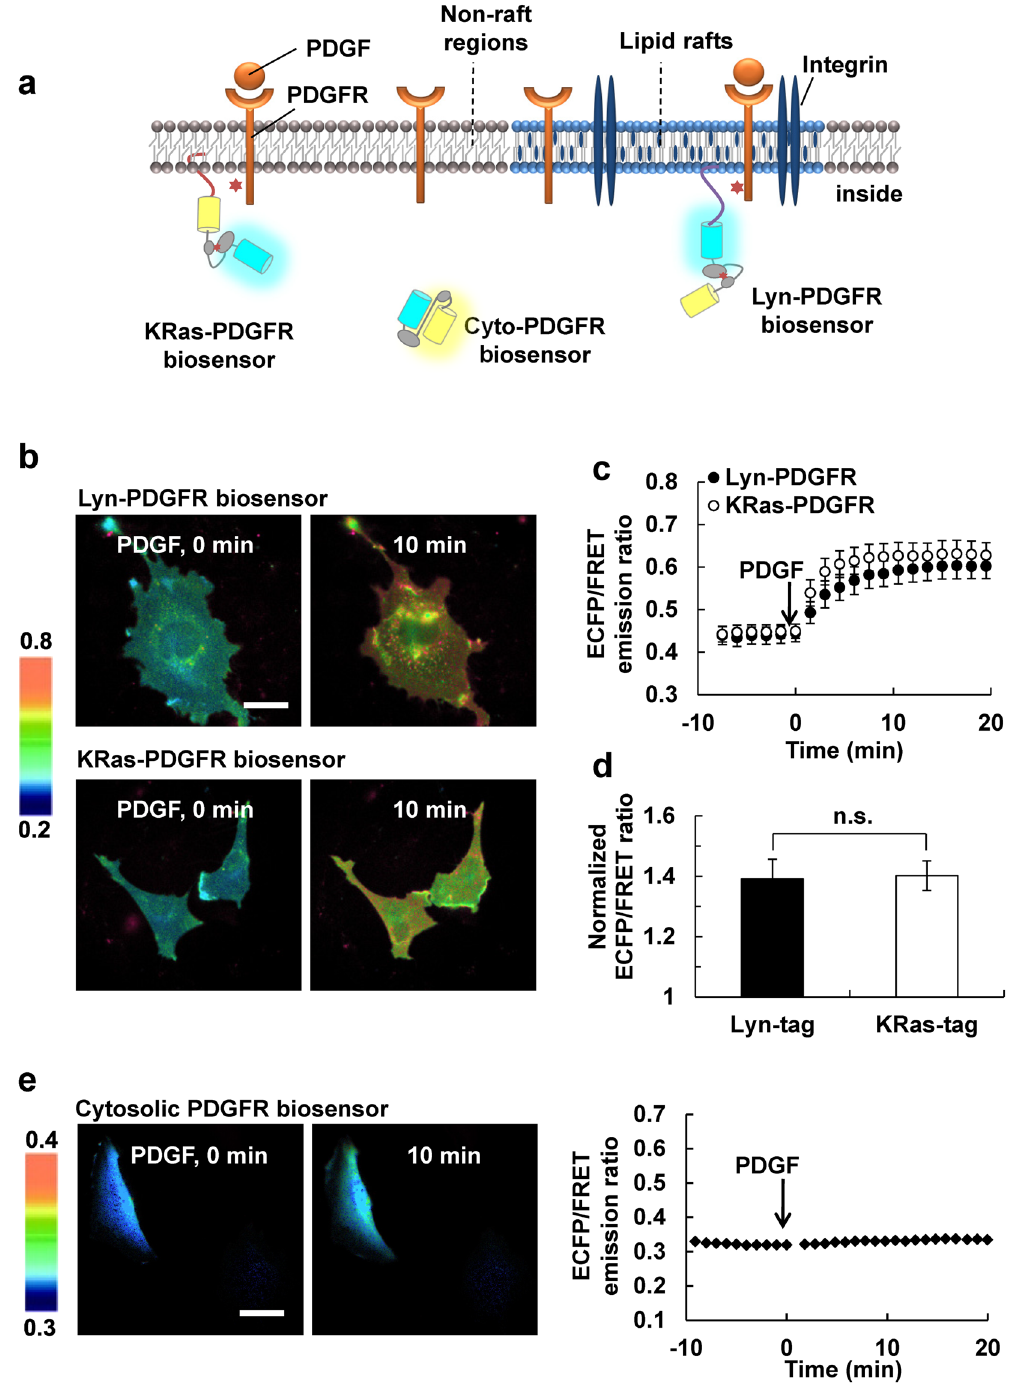
Figure 3. The PDGFR activation occurs both in and outside of lipid rafts. ( a ) The cartoon depicts the different subcellular localizations of cytosolic, Lyn- and KRas-tagged PDGFR biosensors. Lyn-tag contains the acylation signals for the incorporation of the biosensor into lipid rafts microdomains, while the prenylation signal of KRas-tag leads the biosensor to the general membrane regions outside of rafts. ( b ) The representative ECFP/ FRET ratio images of Lyn- and KRas-PDGFR biosensors before and after 10 min of PDGF treatment in MEFs. The color bar on the left represents the values of ECFP/FRET emission ratio of PDGFR biosensor. Bar = 20 μ m. ( c ) The time course of the ECFP/FRET ratio (mean ± s.e.m.) of Lyn- (black circles) and KRas-PDGFR biosensors (white circles) upon PDGF stimulation. ( d ) The normalized ECFP/FRET ratio at the time point of maximal FRET response from Lyn- (black) or KRas-tagged PDGFR biosensors (white) (n = 10). n.s. indicates no significant difference between groups. ( e ) The representative ECFP/FRET emission ratio images and time courses of the cytosolic PDGFR biosensor in response to PDGF treatment. Bar = 20 μ